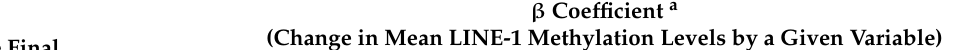
Variables in the